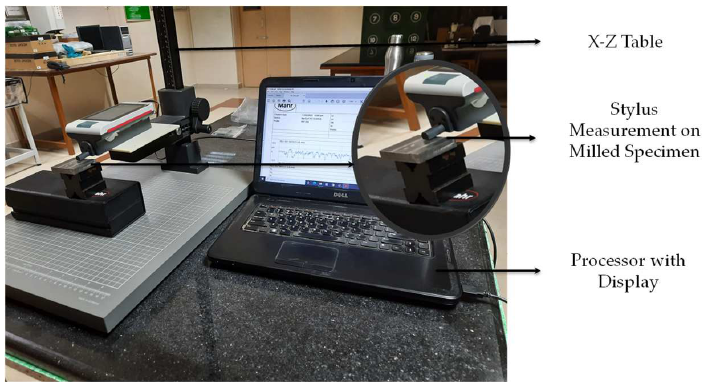
Figure 4. Stylus profilometer .